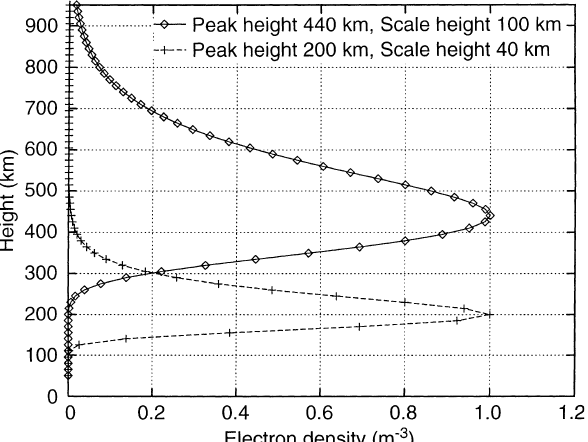
Fig. 1. Vertical electron-density profiles through two background ionospheres